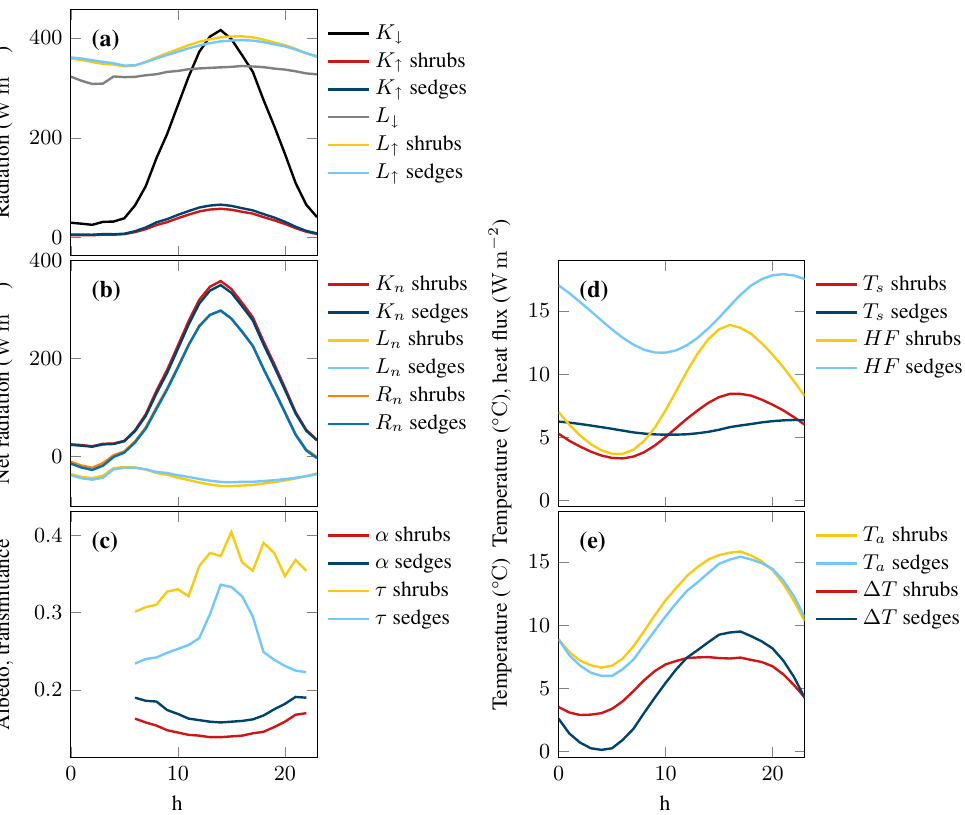
Figure 4. (a) Average diel cycle of above-canopy shortwave ( K ) and longwave ( L ) radiation fluxes, (b) above canopy net shortwave ( K n ), net longwave ( L n ) and net ( R n ) radiation, (c) albedo ( α ) and transmittance ( τ ), (d) soil temperature ( T s ) at 4cm depth and soil heat flux (HF) at 10cm depth, and (e) air temperature at 1 . 7m above the soil surface ( T a ) and gradient between air and soil temperature ( (cid:49)T ) of dwarf shrubs and wet sedges during the growing season; solar noon at 14:00 local time.